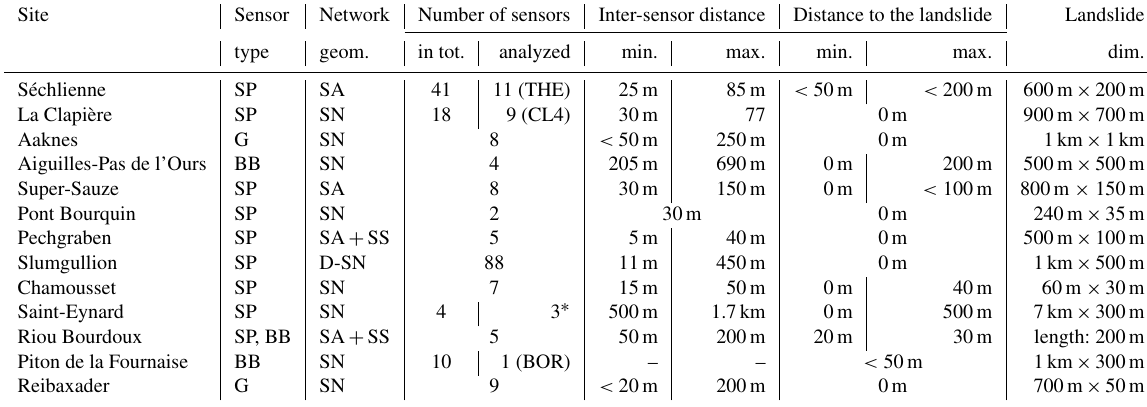
Table 2. Characteristic of the seismic network for the 13 sites analyzed in the present parer. The landslide dimensions are given for the most active area of the slope instabilities (as presented in the published studies). The total number of sensors in the seismic network are given, as well as the minimal and maximal inter-sensor distance and distance to the active zone. In the cases where only a few of the sensors have been investigated in the present study, we indicate the number of the sensors as well as the name of the station in parenthesis.